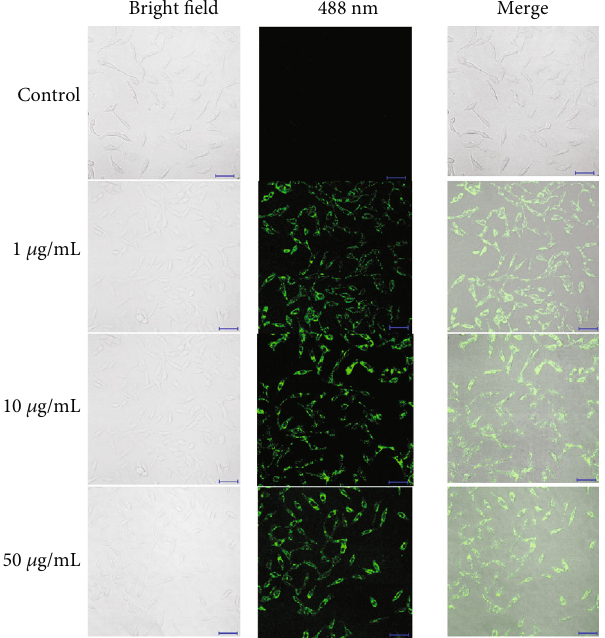
Figure 3: Confocal laser scanning microscopy images of SHEDs incubated with 1, 10, and 50 μ g/mL of GOQDs, respectively, for 3 days. Scale bar, 100 μ